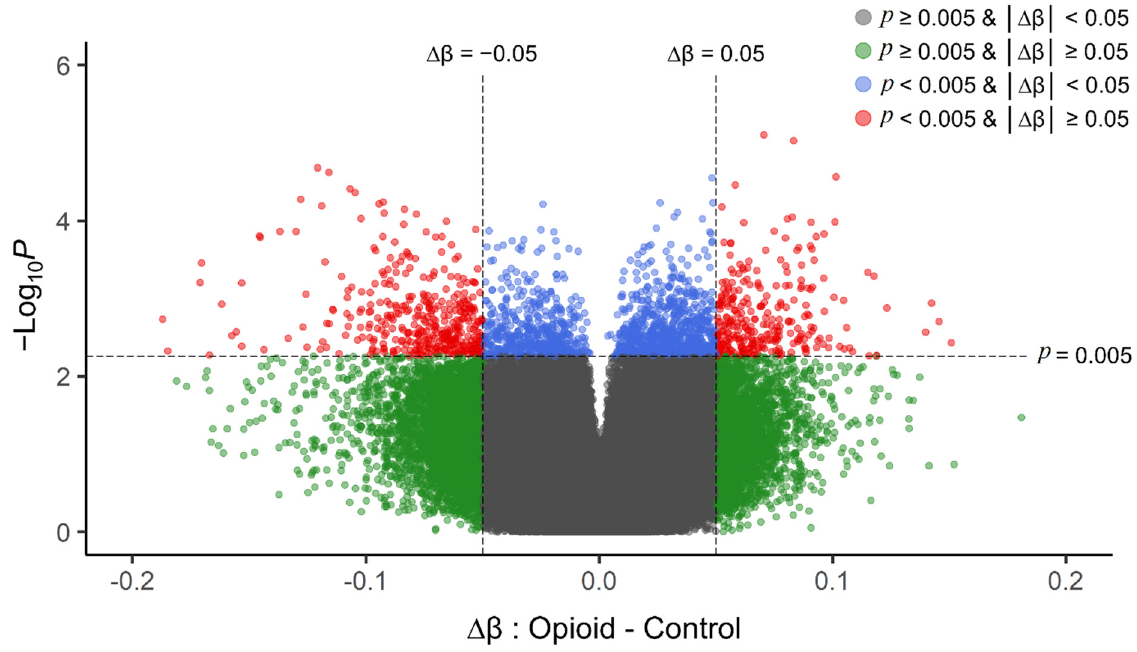
Figure 2. Volcano plot of unadjusted p -values ( y -axis; − Log 10 scale) versus delta beta values (opioid-exposed − controls; x -axis) for each CpG site in the filtered analysis (710,952 probes). Positive delta beta values indicate higher average methylation in opioid-exposed samples versus controls (and negative delta beta values indicate lower average methylation in opioid-exposed samples versus controls). The vertical dashed line represents an absolute delta beta cut-off of | ∆β | ≥ 0.05 (green dots), the horizontal dashed line represents an unadjusted p -value cut-off of p < 0.005 (blue dots), and sites that met both cut-offs are shown in red. These top sites (red) were used as the input for subsequent enrichment analyses. The grey dots represent those CpG sites with | ∆β | < 0.05 and p > 0.005. p -values were obtained from differential methylation analysis in limma (effect of opioid with fetal sex, fetal body weight, and batch as covariates).